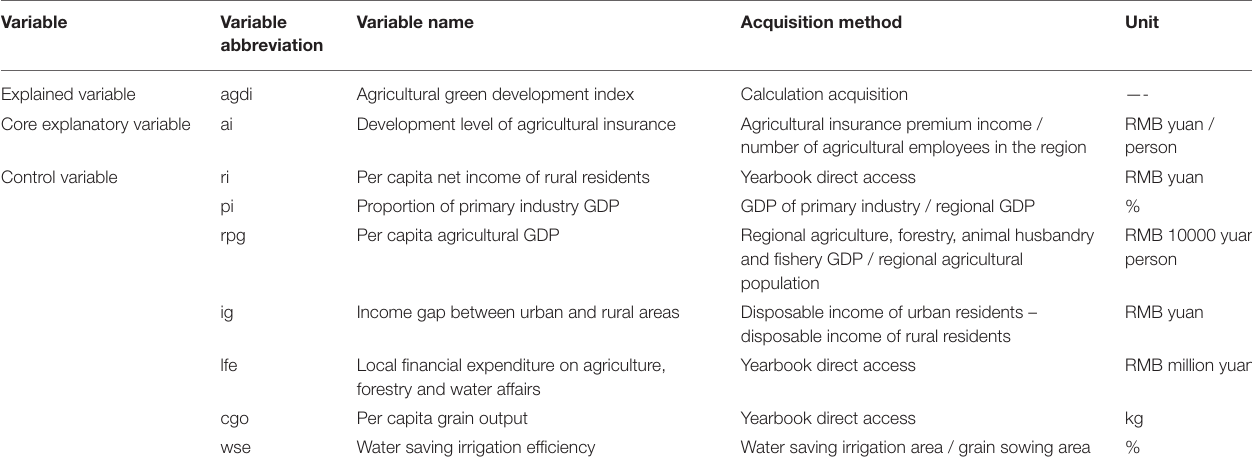
TABLE 5 | Relevant variables and description.